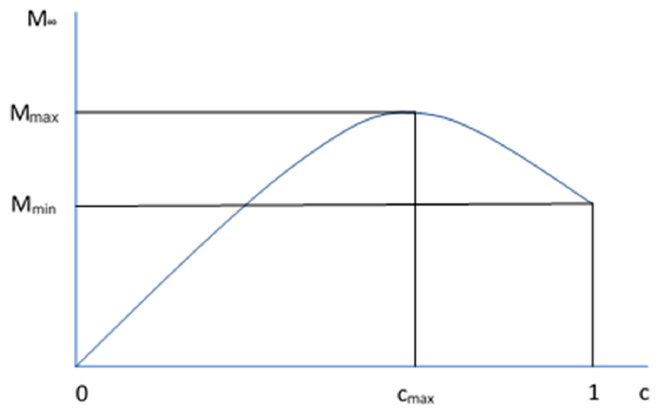
Figure 4. Schematic representation of the M ∞ dependency for the total surfactant concentration during the sponge compression [8].